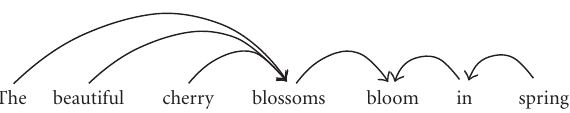
Figure 3: Example of dependency structure.